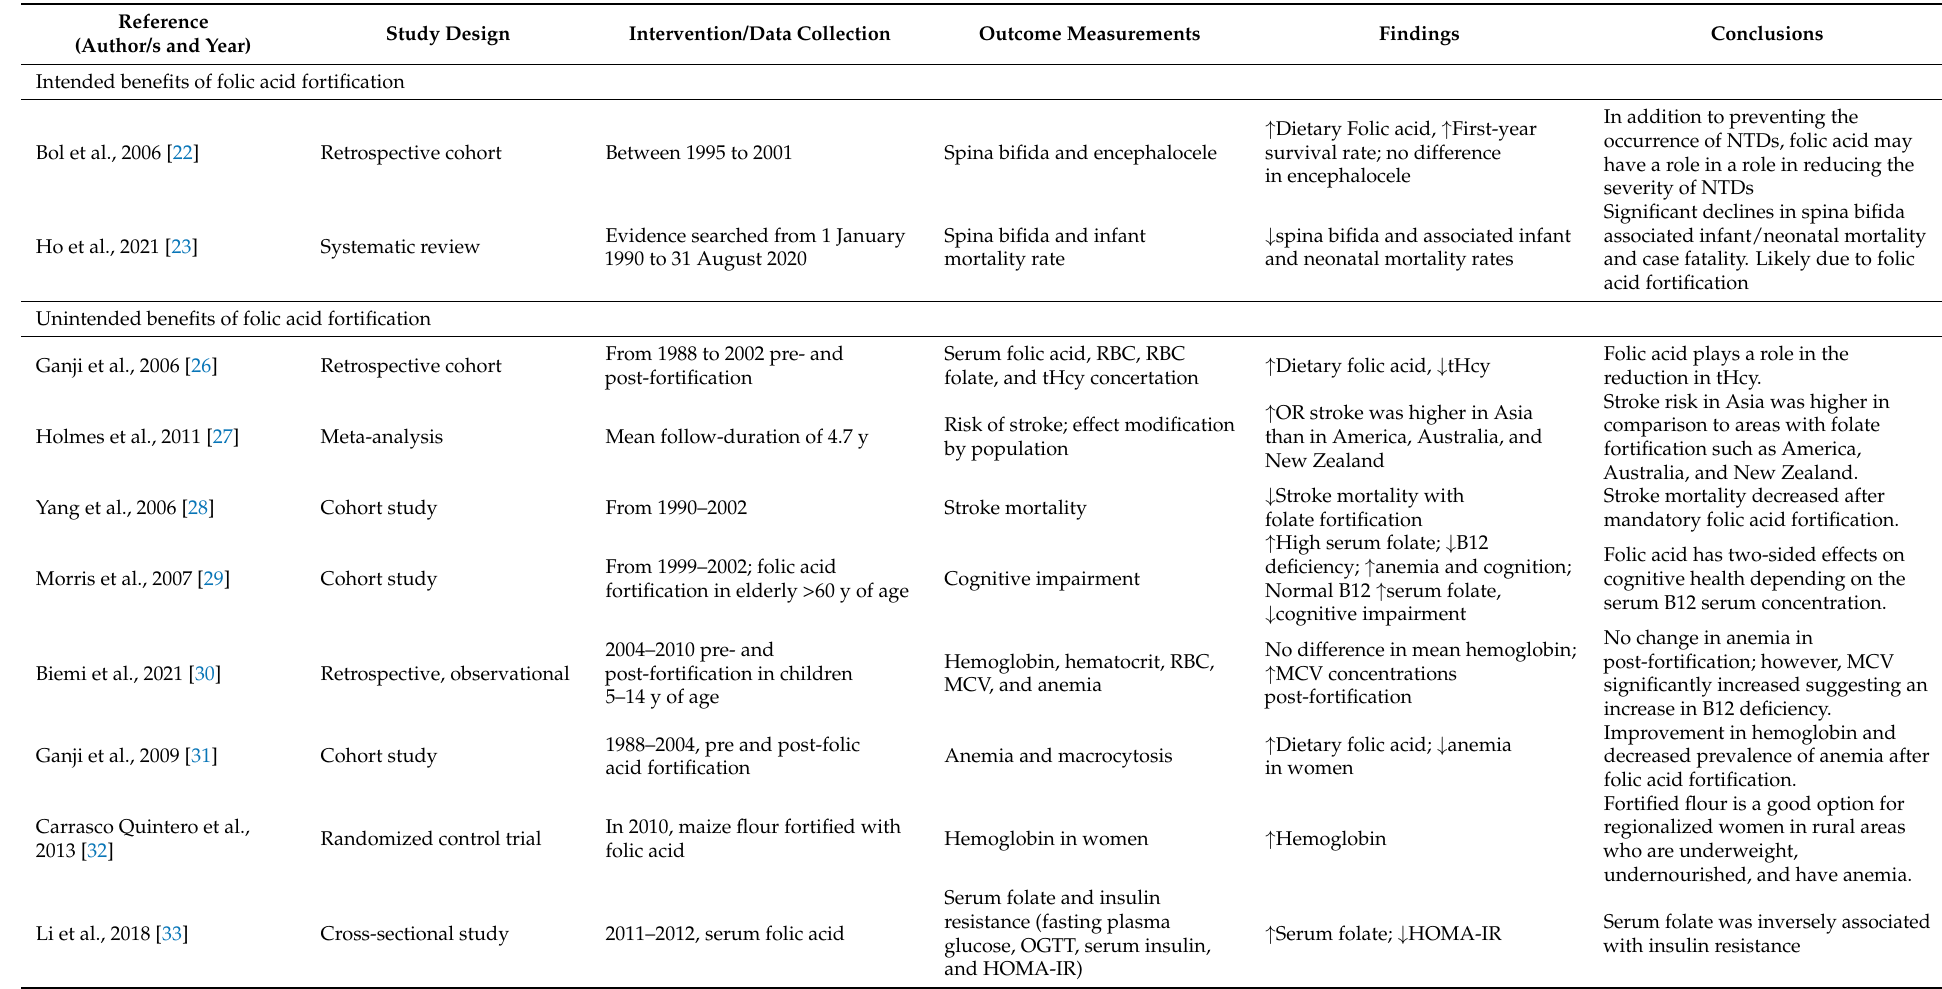
Table 1. Summary of studies that assessed health benefits of folic acid fortification 1